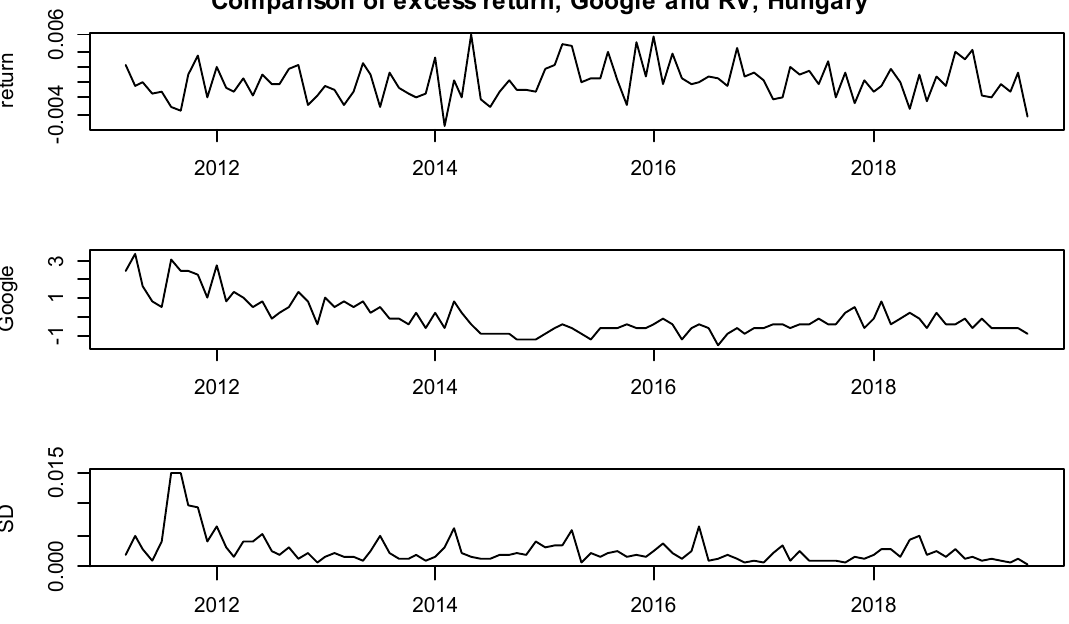
Figure A1. Comparison of monthly series: Excess return, RV and Google search volume, Serbia.